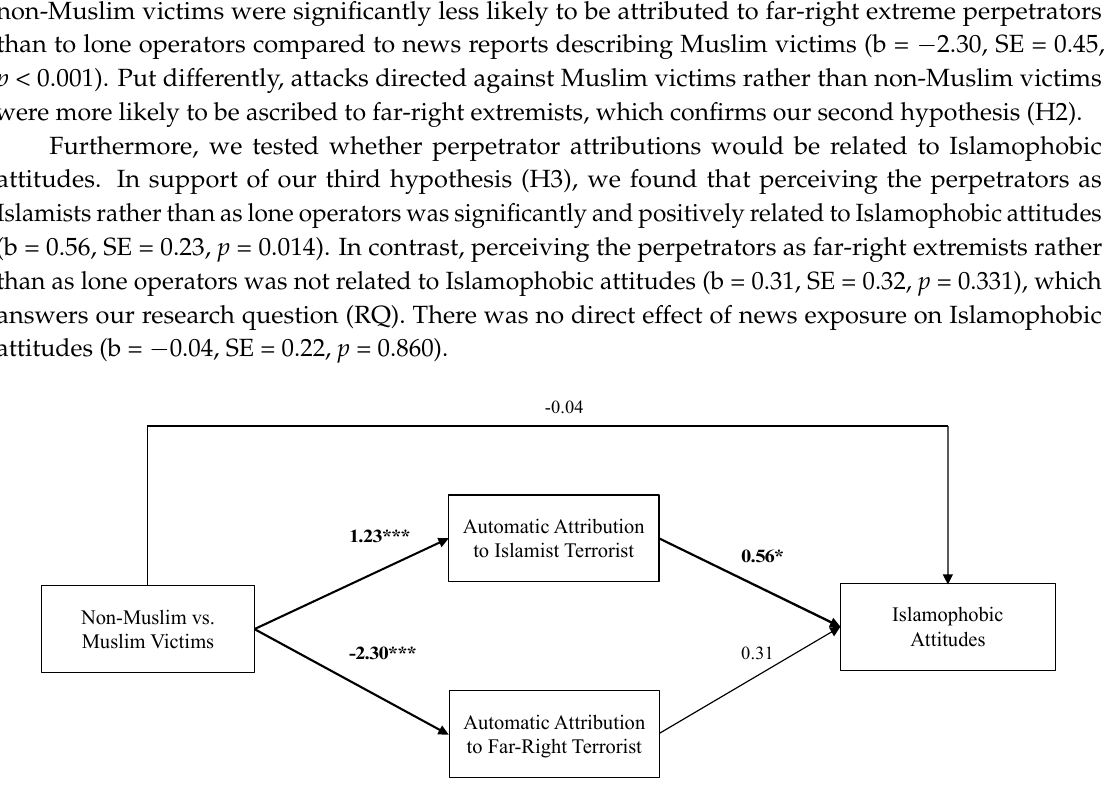
Figure 2. Unstandardized path coefficients. Bold lines indicate significant effects. * p < 0.05; *** p < Figure 2 . Unstandardized path coefficients . Bold lines indicate significant effects . * p < 0.05; *** p < 0.001.